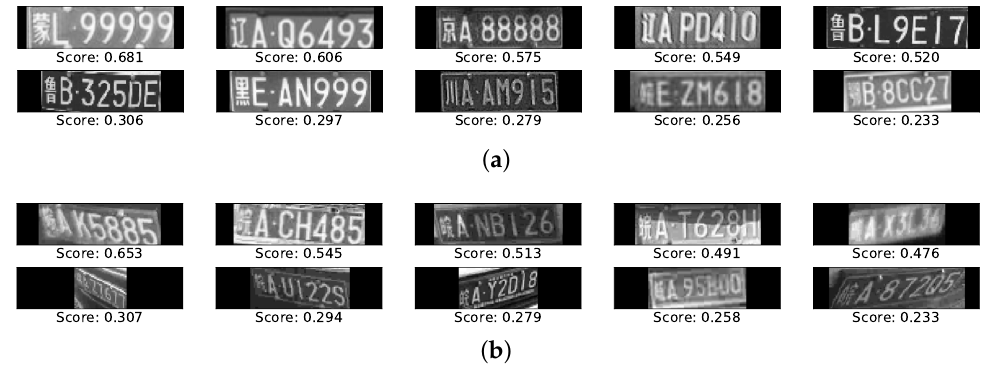
Figure 12. Samples license plate images from CLPD ( a ) and CCPD Challenge subset ( b ) with the corresponding quality